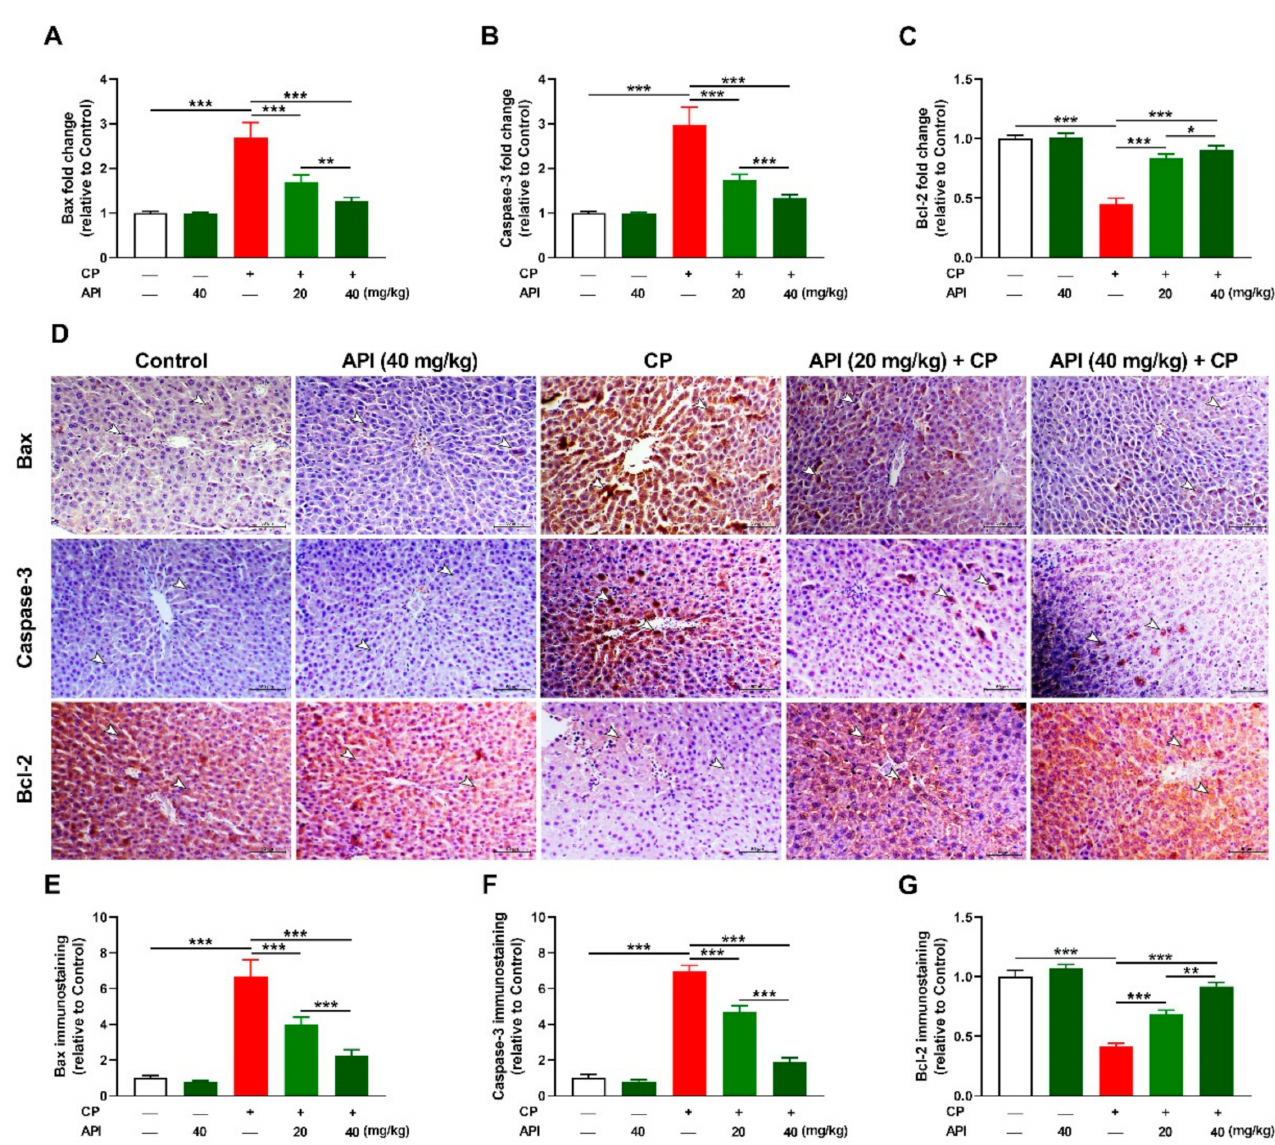
Figure 8. API prevented CP-induced hepatocyte apoptosis in rats. API decreased ( A ) Bax and ( B ) caspase-3 and increased ( C ) Bcl-2 mRNA in CP-administered rats. ( D ) Immunostaining of Bax, caspase-3, and Bcl-2, and ( E – G ) image analysis showing decreased ( E ) Bax and ( F ) caspase-3 and increased ( G ) Bcl-2 in CP-intoxicated rats treated with API. Data are mean ± SEM, ( n = 6). * p < 0.05, ** p < 0.01, and *** p <